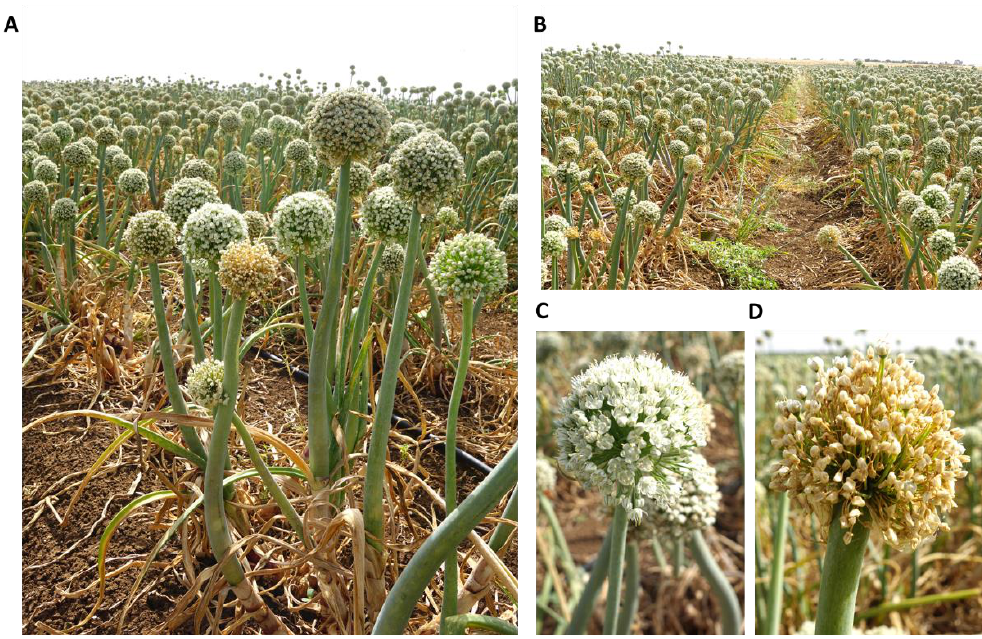
Figure 1. Allium cepa (white onion, Riverside cv.) flower symptoms. The commercial field is located near Kibbutz Ortal (northern Golan Heights, northeastern Israel) and photographed on 30 August 2017. The dehydrated inflorescences were scattered in the field ( A , B ). While the healthy plants had white inflorescences ( C ). The diseased, dried, plant had a yellowish to brown color inflorescences ( D ).